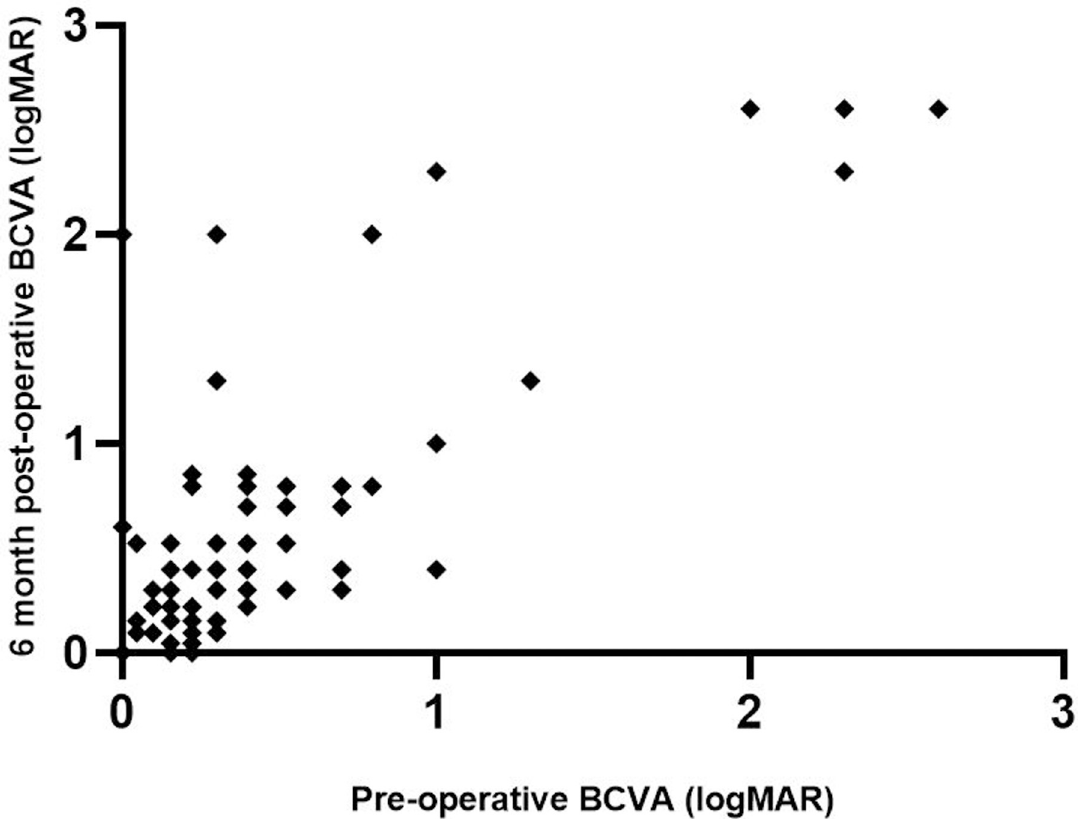
Fig 4. Kaplan-Meier plots representing the probability of being free of hypotony (A), macular edema (B) and > 2 Snellen lines of visual loss (C) over time.